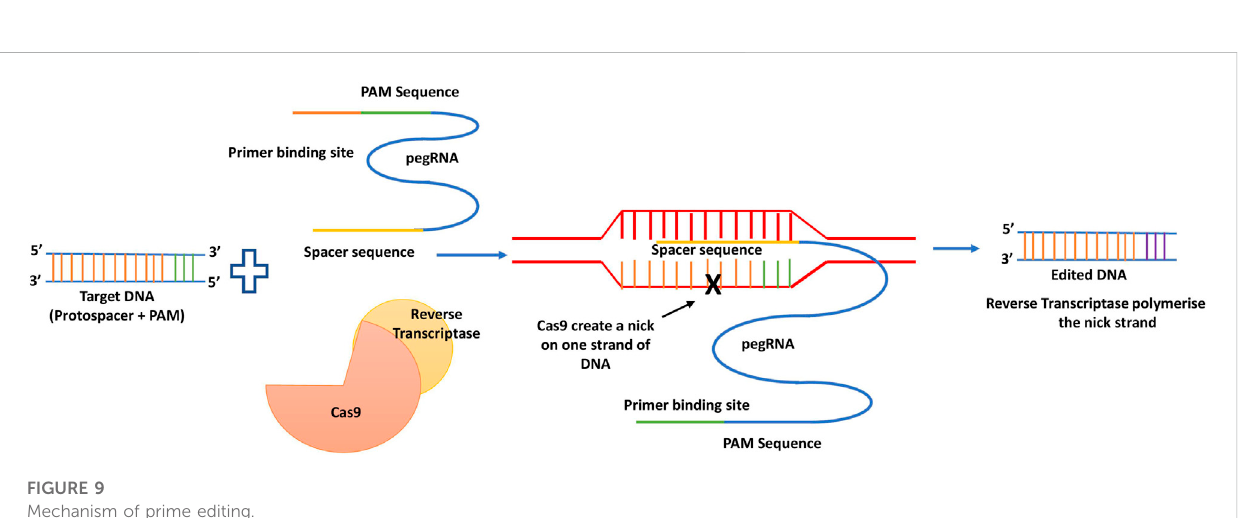
FIGURE 9 Mechanism of prime